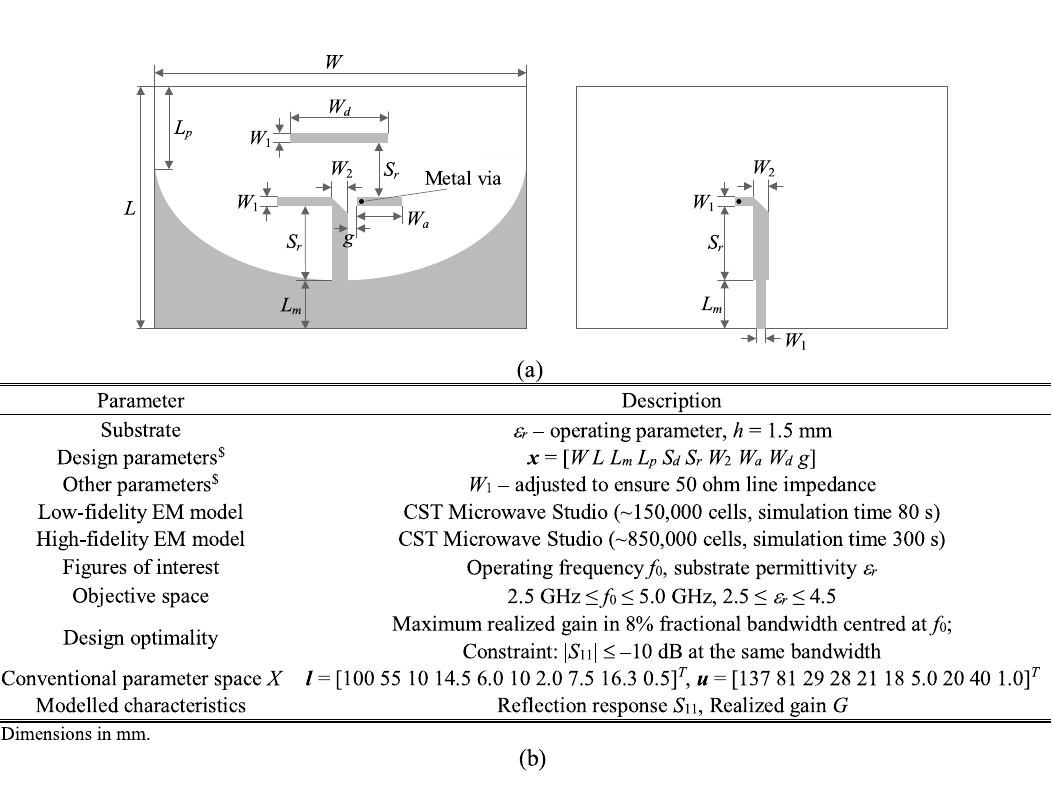
Figure 10. Antenna III: qasi-Yagi antenna with parabolic reflector: ( a ) antenna geometry, ( b ) antenna